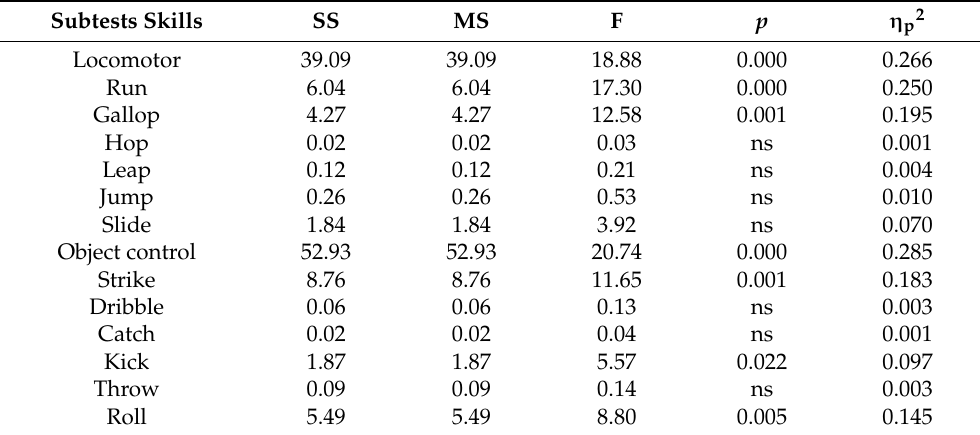
Table 2. Analysis of covariance for the locomotor and object control skills by group